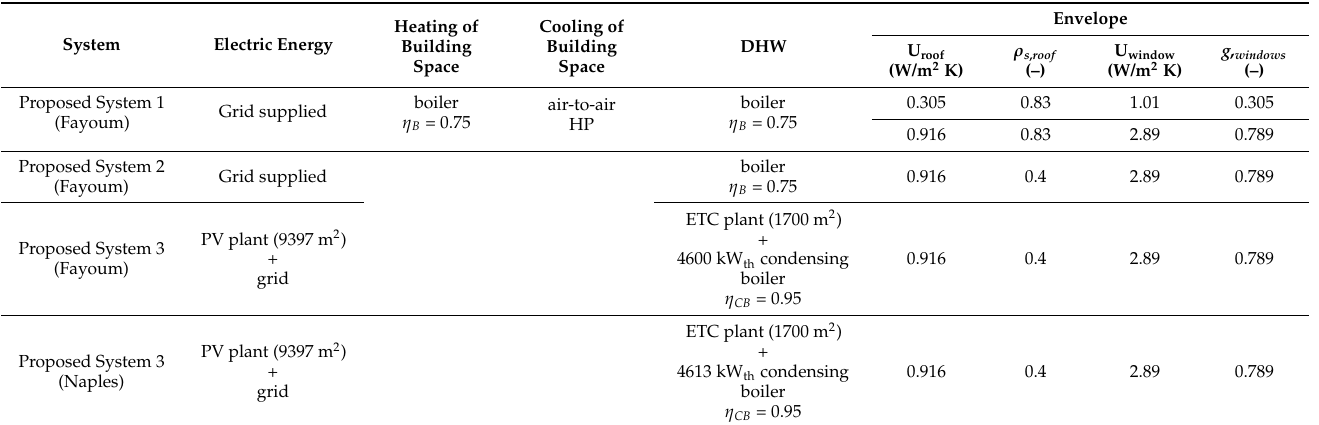
Table 7. Input parameters for the reference and proposed systems. DHW: domestic hot water.